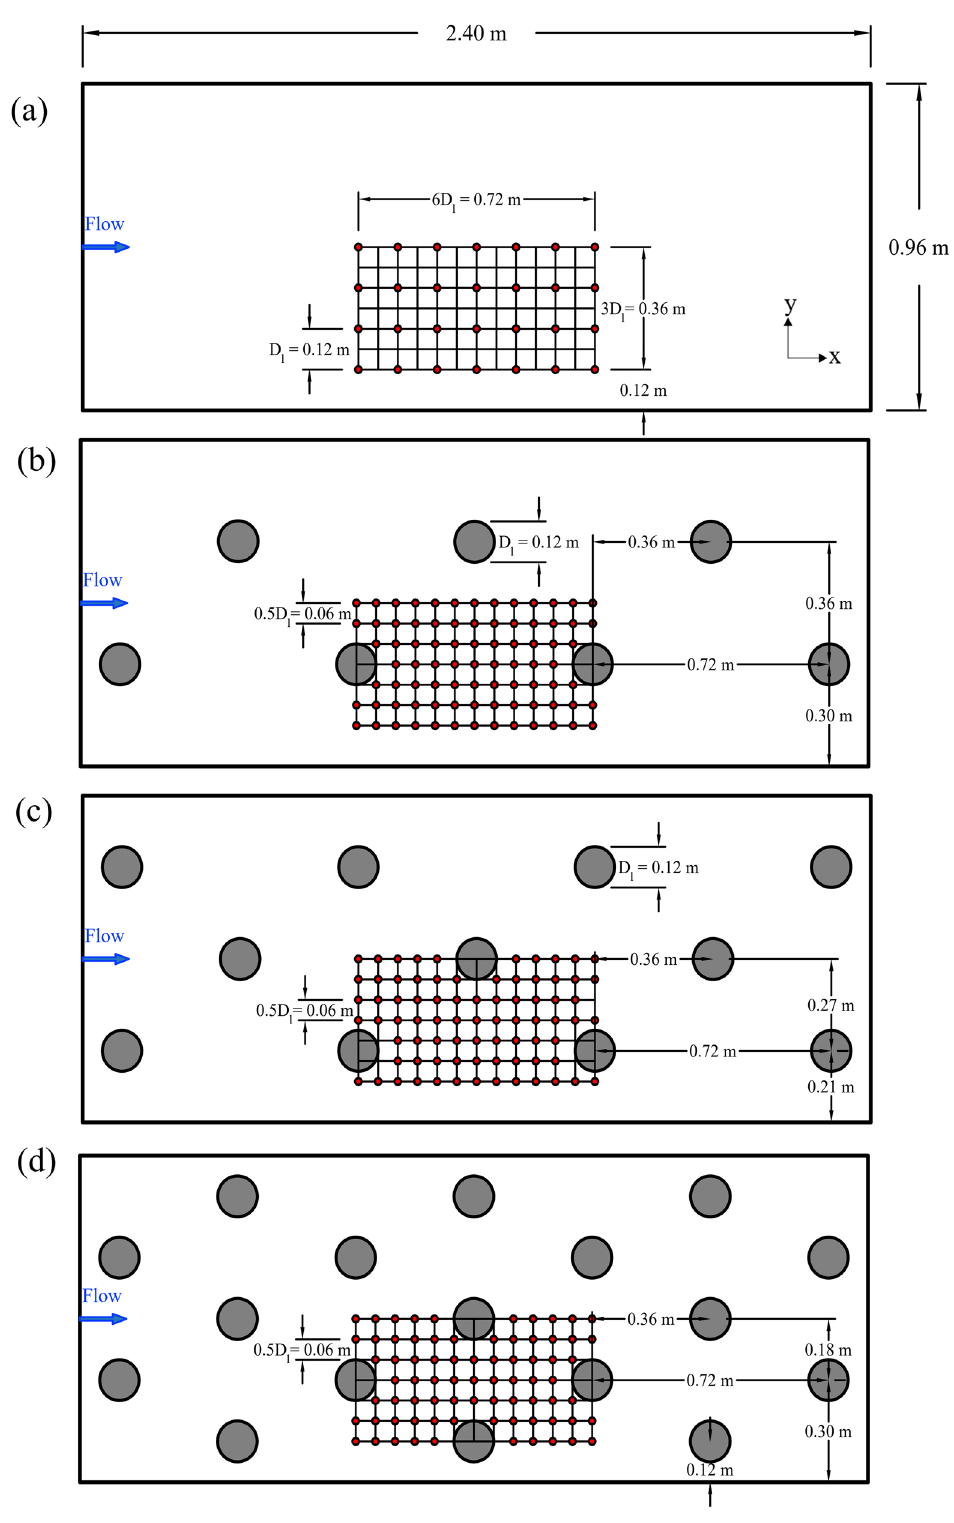
Figure 2. Scheme of the general measurement zone for experimental scenarios ( a ) S1-L and S1-H (no boulder scenarios), ( b ) S2-L and S2-H (λ = 3.4%), ( c ) S3-L and S3-H (λ = 5.4%), ( d ) S4-L and S4-H (λ = 8.3%). The grid shows the detailed measurement zone and orange circles show the location of measuring